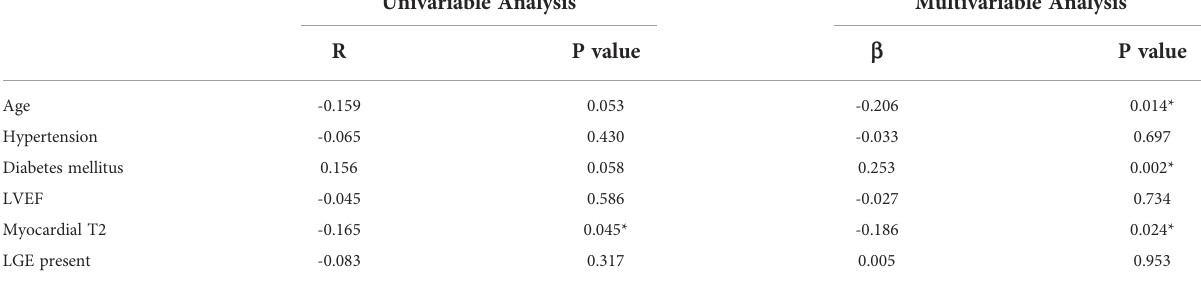
TABLE 3 The risk factors of indexed LV mass by univariable and multivariable